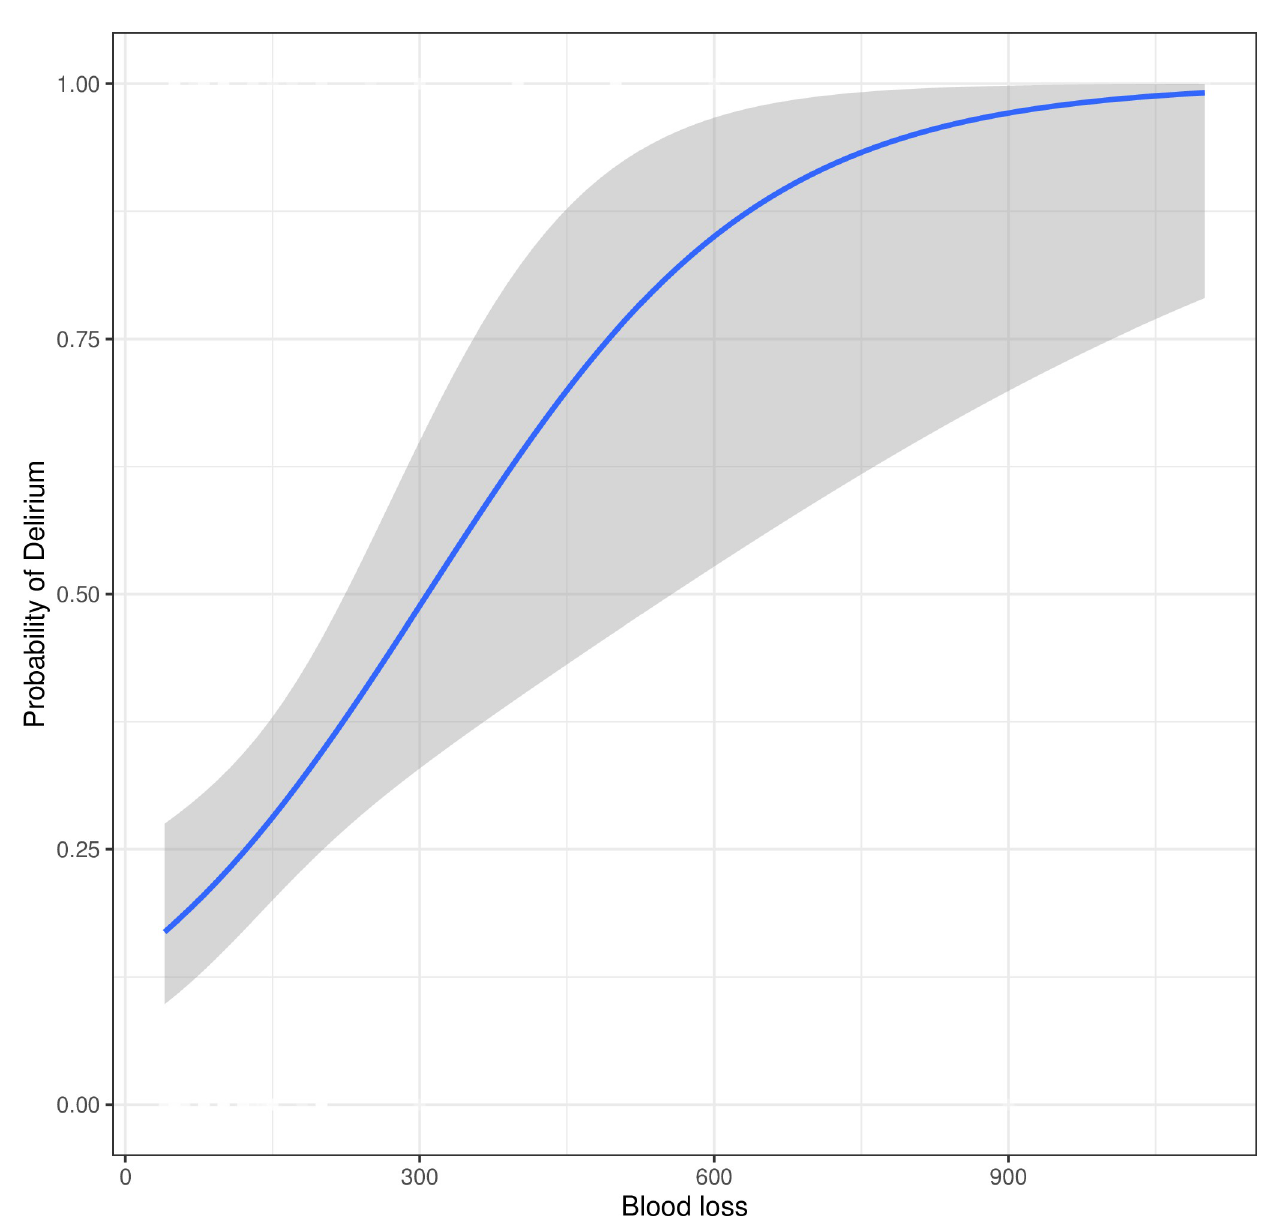
Fig 4. The association between blood loss and probability of delirium.